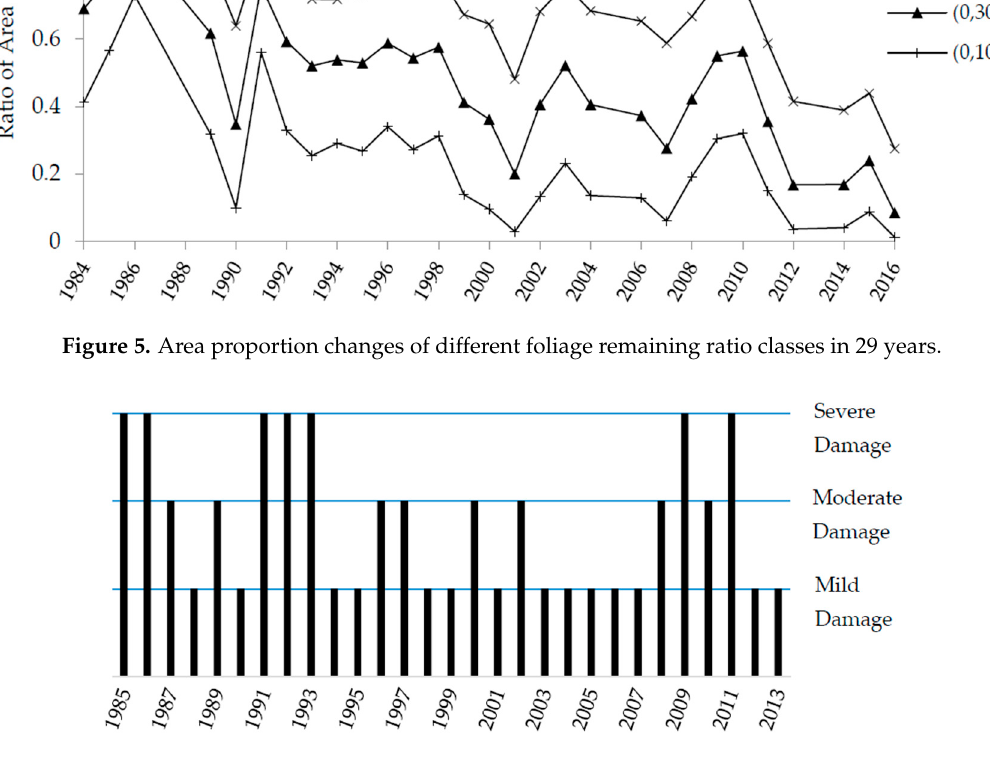
Table 2. Correlations between average foliage remaining ratio of 28 years and meteorology.